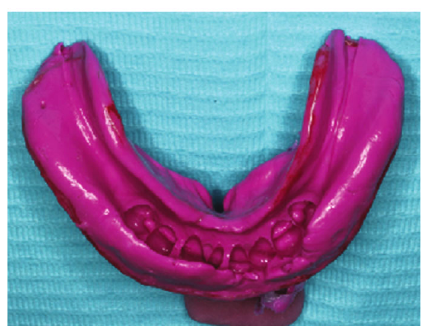
Figure 10: Pick-up impression of primary metal coping.